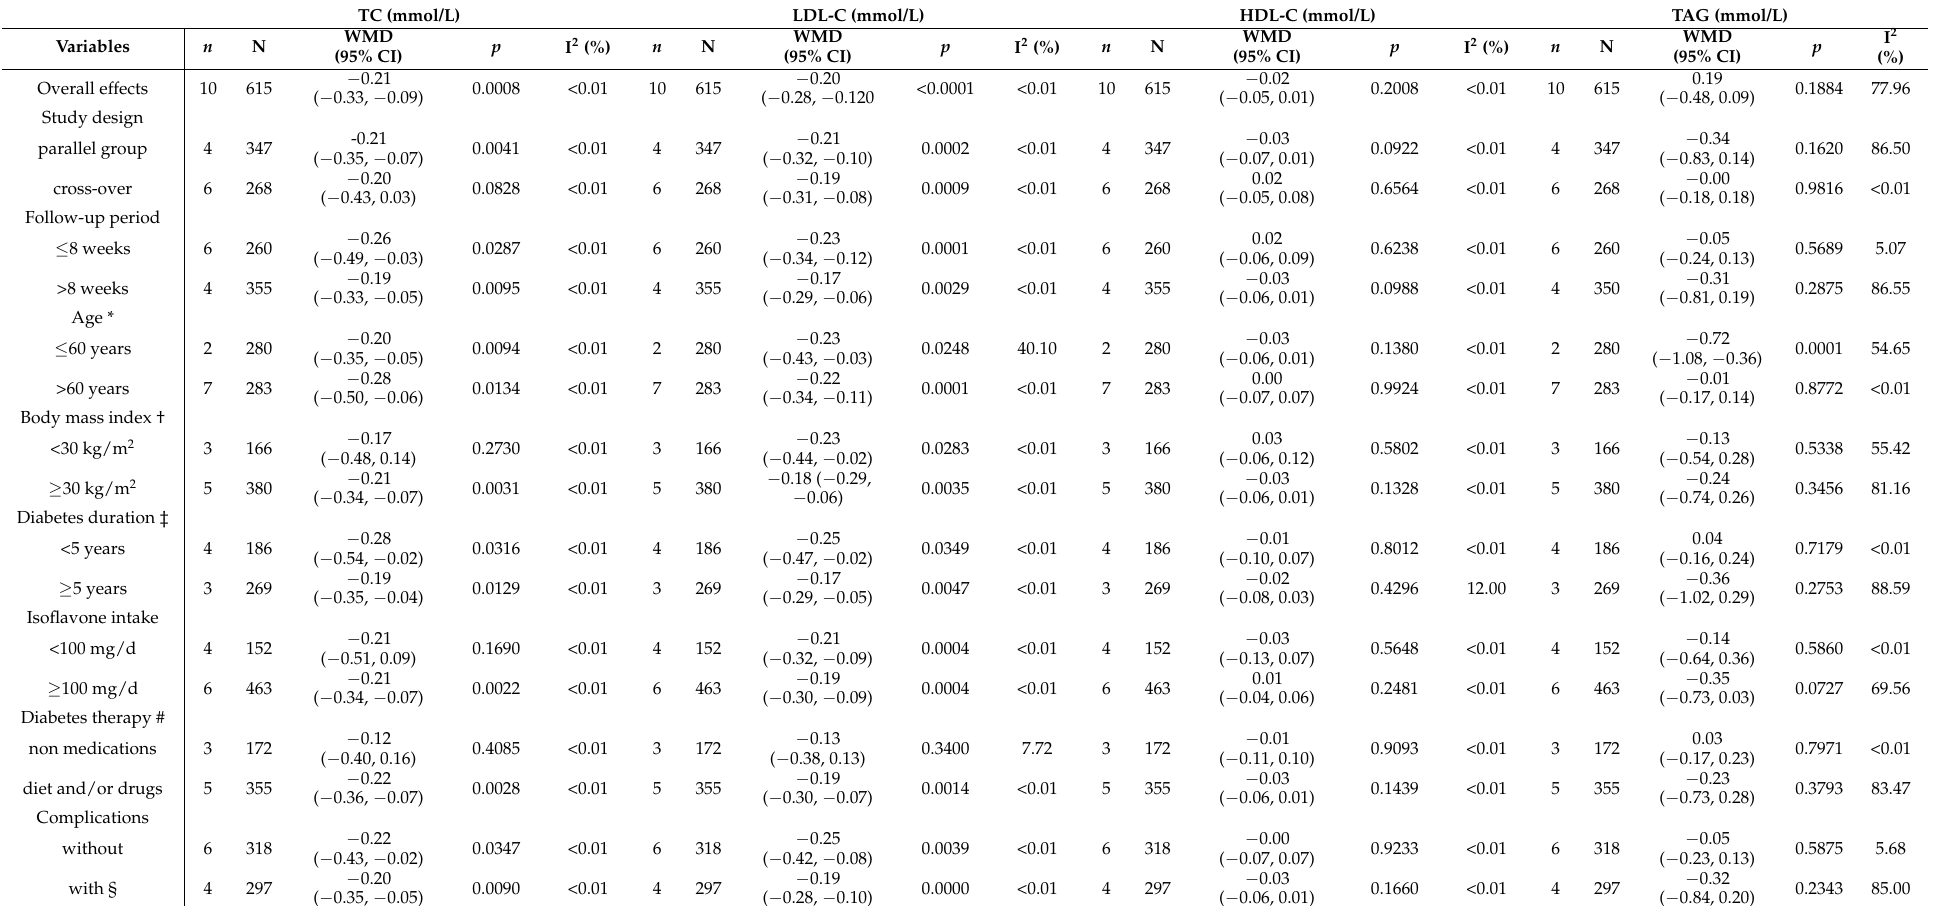
Table 3. Pooled estimates of treatment effect on lipid profile in subgroups of